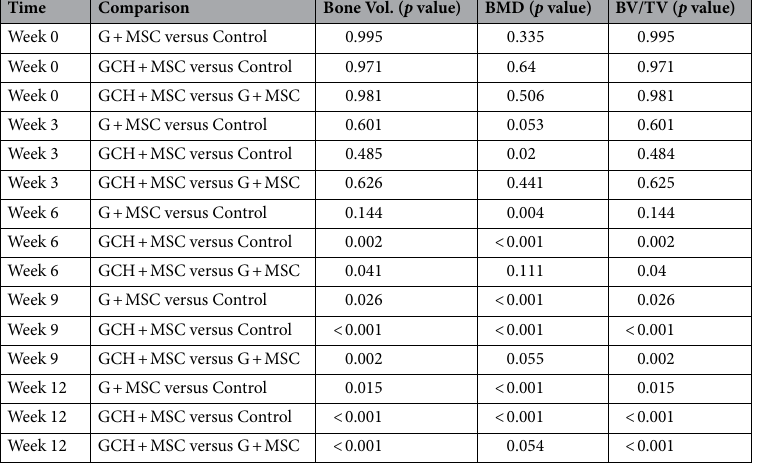
Table 2. Holm-Sidak comparison of bone morphometry parameters between conditions. (Control = No microgel control, G + MSC = Gelatin microgels seeded with MSC, GCH + MSC = Gelatin microgels with chitosan and HA seeded with